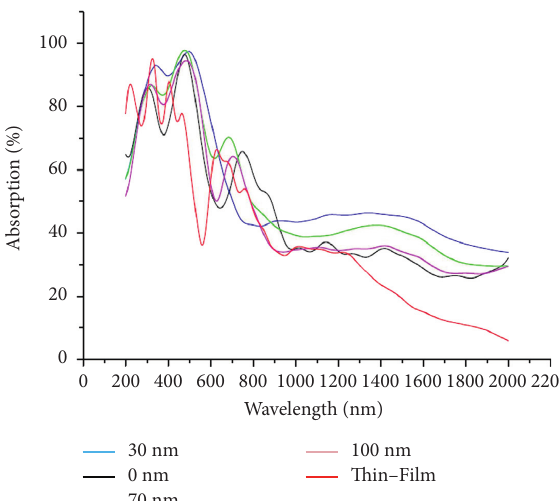
Figure 5: Absorption as a function of wavelength for thin-film (red curve), CdS shell thickness of 30 nm (blue curve), CdS shell thickness of 70nm (green curve), CdS shell thickness (black curve), and CdS shell thickness of 100nm (cyan curve).